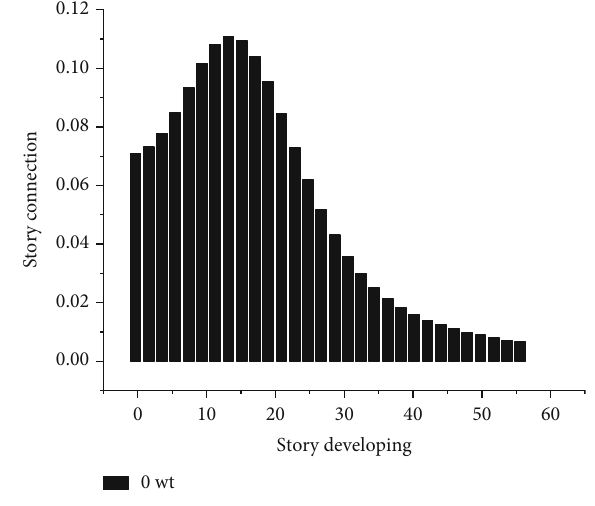
Figure 9: Story source